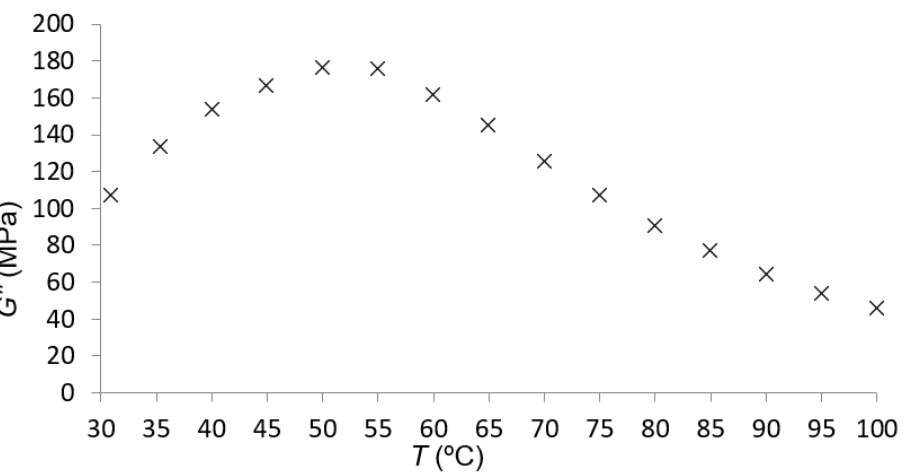
Figure 4. Loss modulus – temperature plot for PA66.